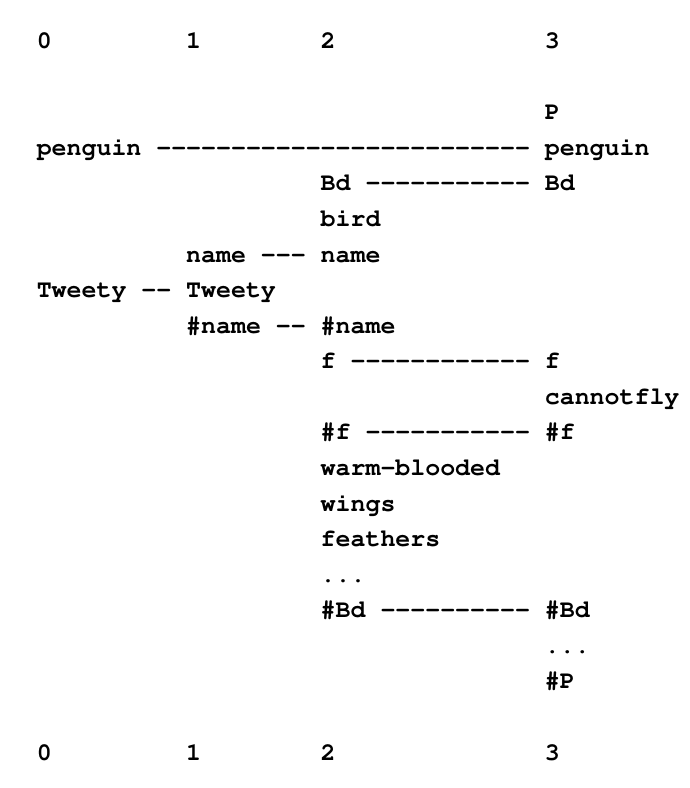
Figure 20. The best multiple alignment formed by the SP model with “ penguin Tweety ” in New and patterns in Old, as described in the text. The relative probability of this multiple alignment is 1.0.